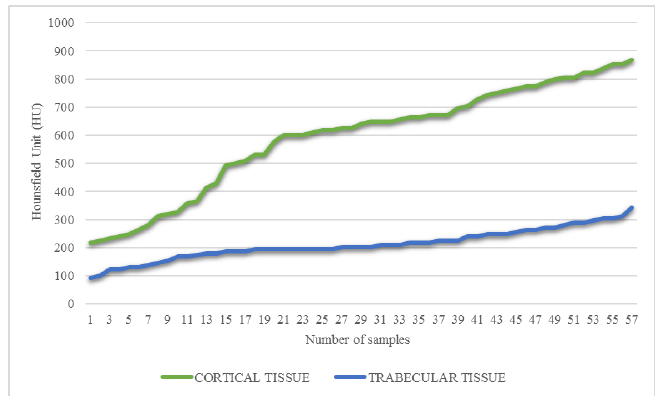
Figure 4. Values (HU) along the tomography of an affected femur with OI.